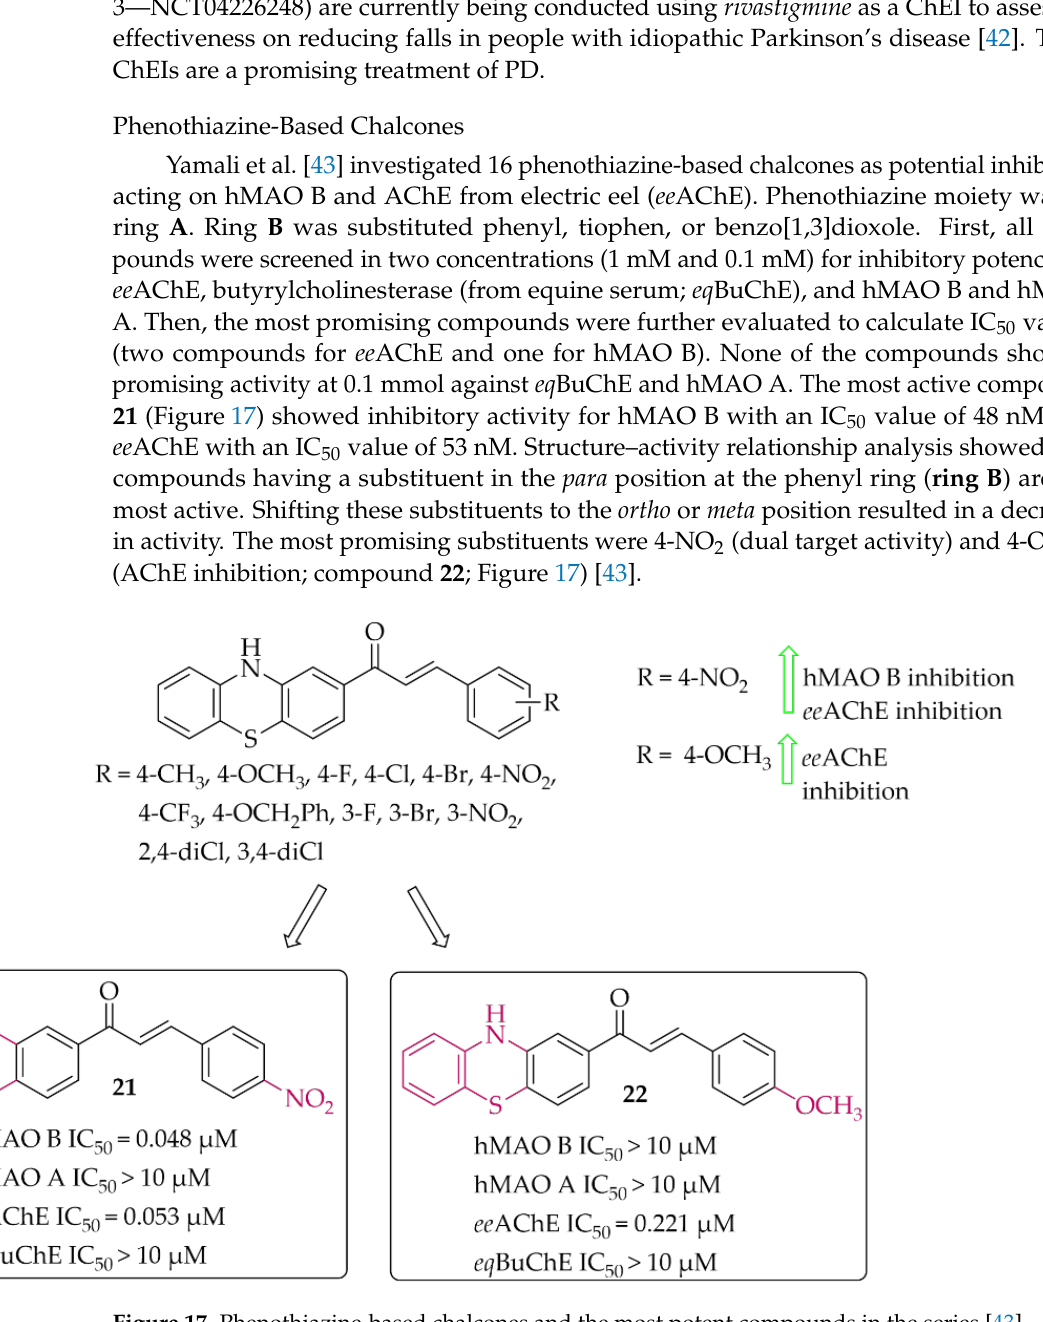
Figure 17. Phenothiazine-based chalcones and the most potent compounds in the series [43].